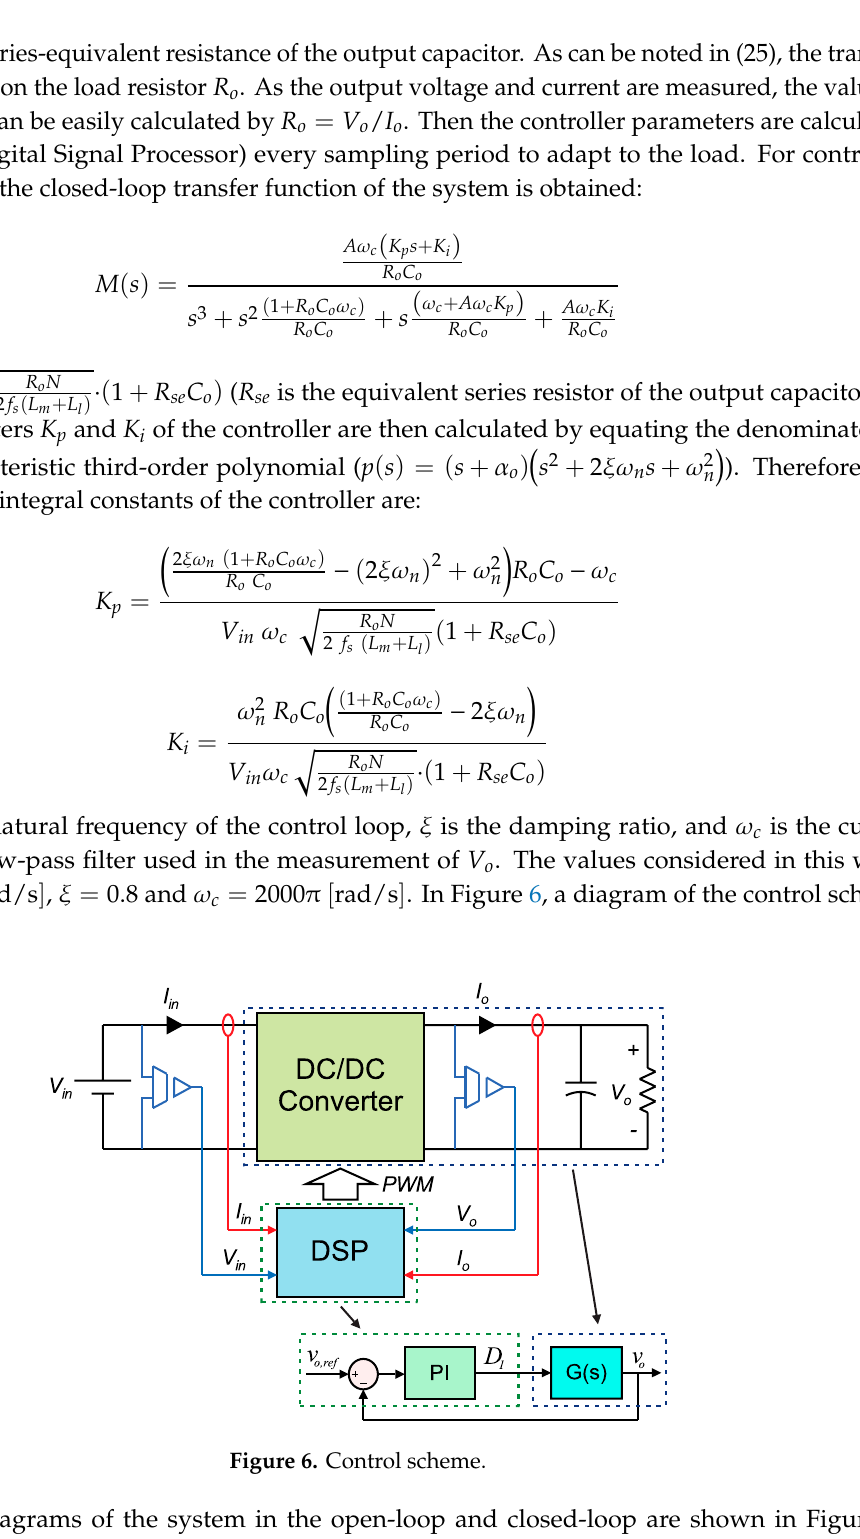
Figure 7. Open-loop Bode diagram of the system.